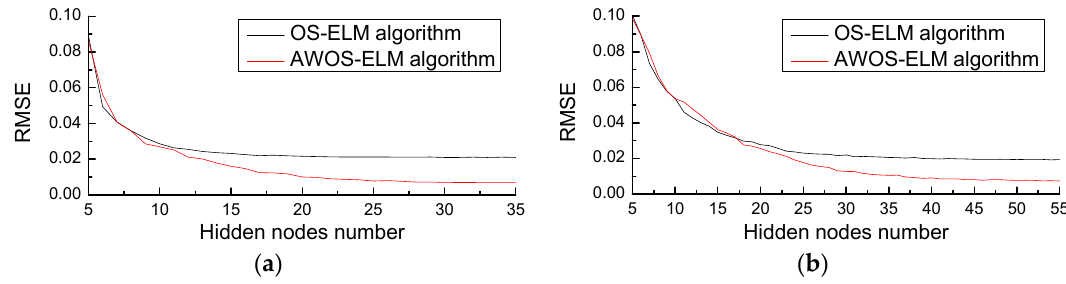
Figure 3. Relationship between testing RMSE and hidden nodes number. ( a ) Sigmoid node; ( b ) RBF node.